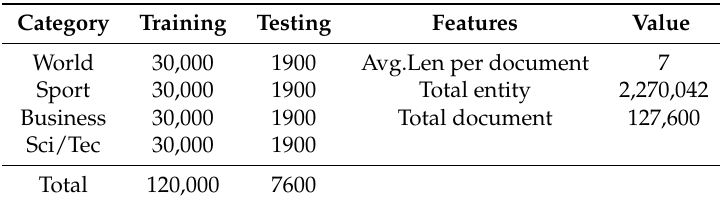
Table 3. The AG news data